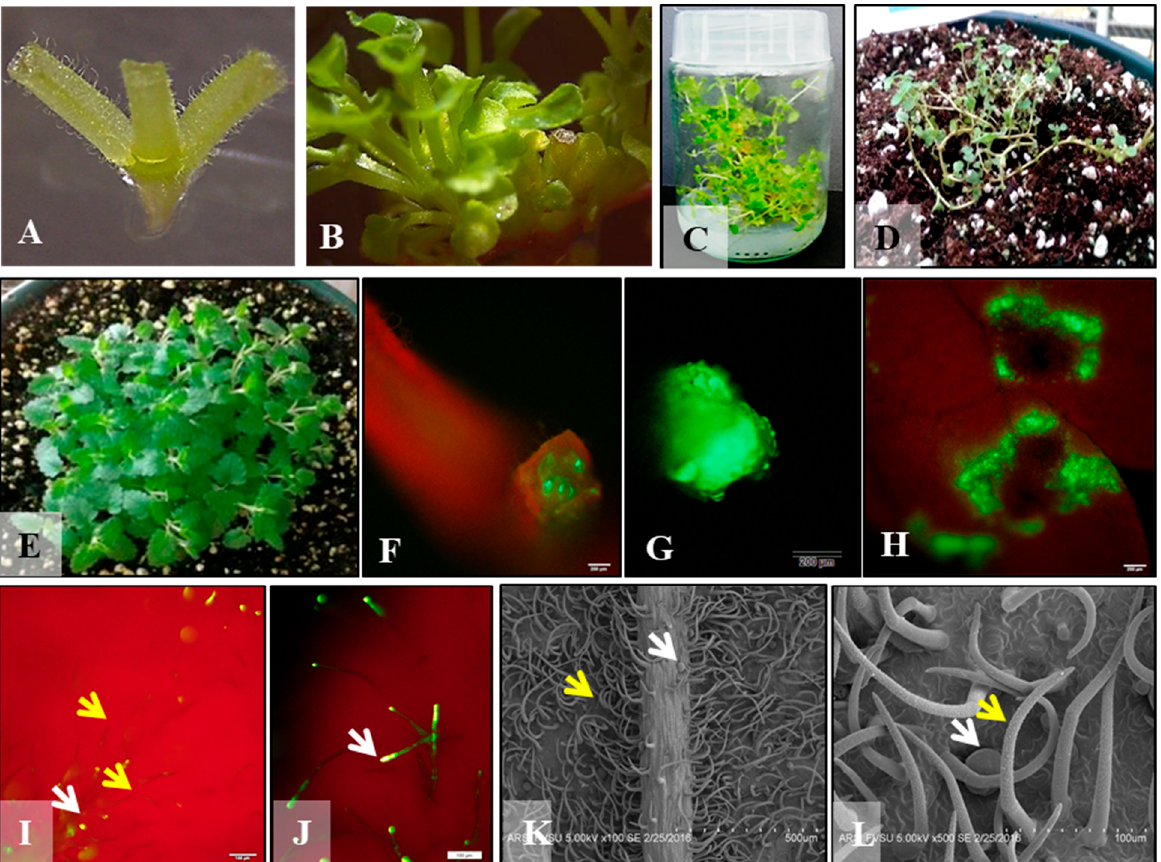
Figure 1. A nodal explant ( A ), A nodal explant in elongation medium with multiple shoots after 10 days incubation on MS medium + 10 µM BAP ( B ), Fully grown, elongated plantlets on MS basal medium ( C ), Ex vitro plantlet in a potting medium under intermittent mist in the greenhouse ( D ). Hardened plant in the greenhouse ( E ), GFP expression on the node, at the cut end of an internode, and wounded areas on S. havanensis leaf ( F – H ). Fluorescent staining differentiating non-glandular and glandular trichomes ( I ), Fluorescent detection of secondary metabolites in glandular trichomes ( J ), Scanning electron micrograph of abaxial leaf surface showing dense non-glandular trichomes ( K ). Glandular and non-glandular trichomes on the adaxial leaf surface. Yellow arrow: Non-glandular trichomes; White arrow: Glandular trichomes ( L ).